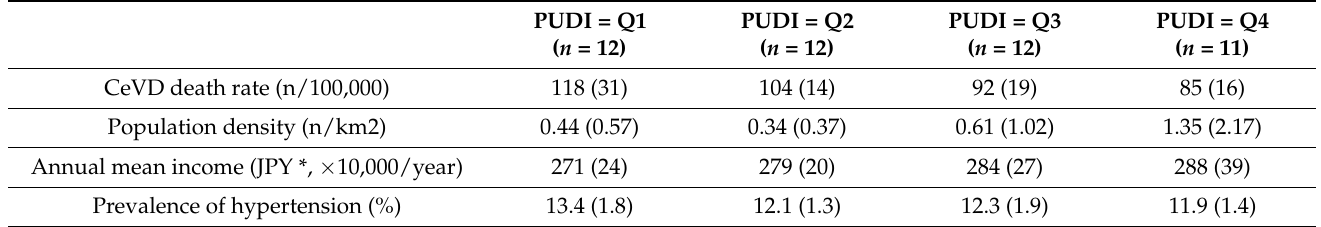
Figure 2. ( A ) CeVD death rate among the 47 prefectures of Japan divided into quartiles by Physician Uneven Distribution Index (PUDI) ( p -value for trend: Q1= 0.1266, Q2= 0.0004, Q3= 0.0046, and Q4 = 0.0093) and ( B ) increasing disparity of CeVD death rate indicated by increasing Gini index between 1998 and 2018. Table 1. Baseline characteristics by quartile of Physicians Uneven Distribution Index (PUDI).